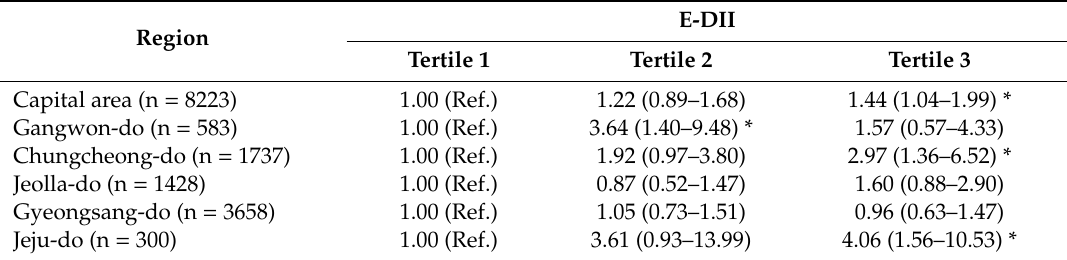
Table 4. Associations of energy-adjusted dietary inflammatory index (E-DII) scores with the risk of depression and depressive symptoms by six regions in Korea. Region